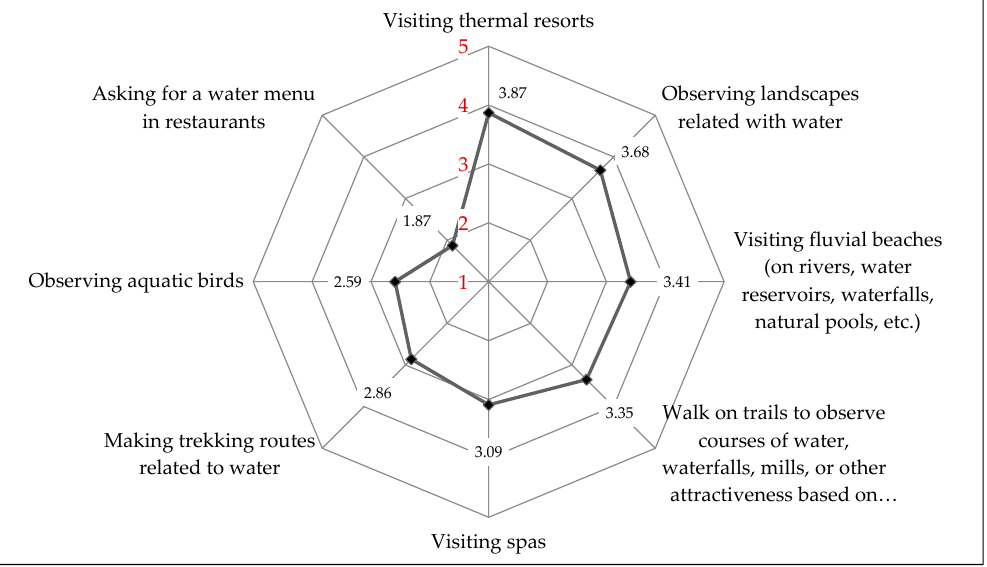
Figure 3. Interest in water-based tourist experiences (means). Graph 3. Perceptions about the water-based tourism experiences (means).